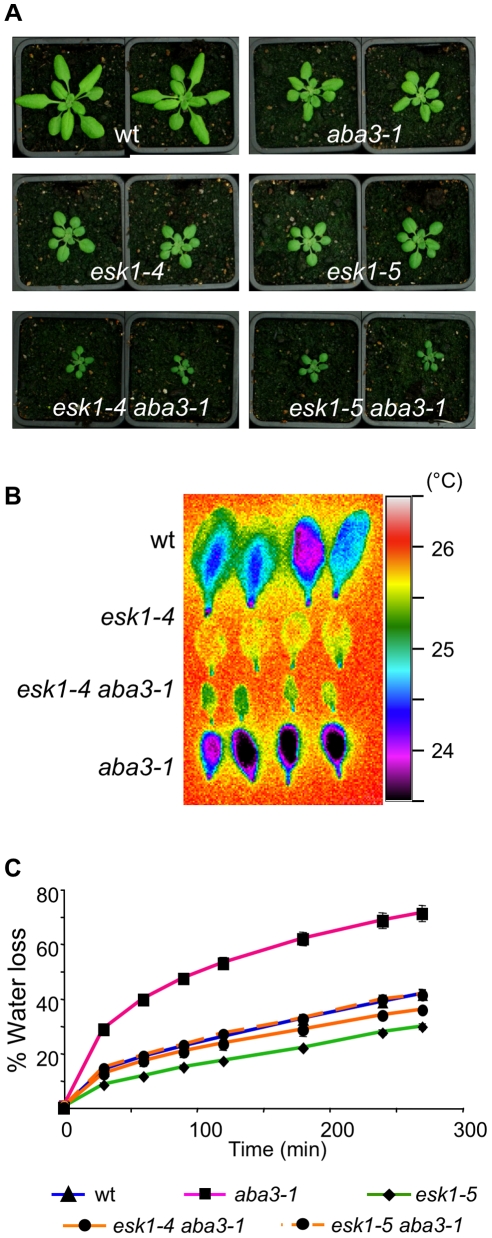

esk1 aba3-1 double mutants phenotypes.A. Two representative plants of each genotype grown in standard non-stressed conditions: wild type (wt), aba3-1, esk1-4, esk1-5, esk1-4 aba3-1 and esk1-5 aba3-1 double mutants. B. False color infrared image of detached leaves from 4 week-old plants, 2 leaves from 2 plants were observed for each genotype. C. Rapid dehydration of detached rosettes from 4 week-old plants. Water loss was determined as % of initial fresh weight. Error bars represent standard error values (n = 4).